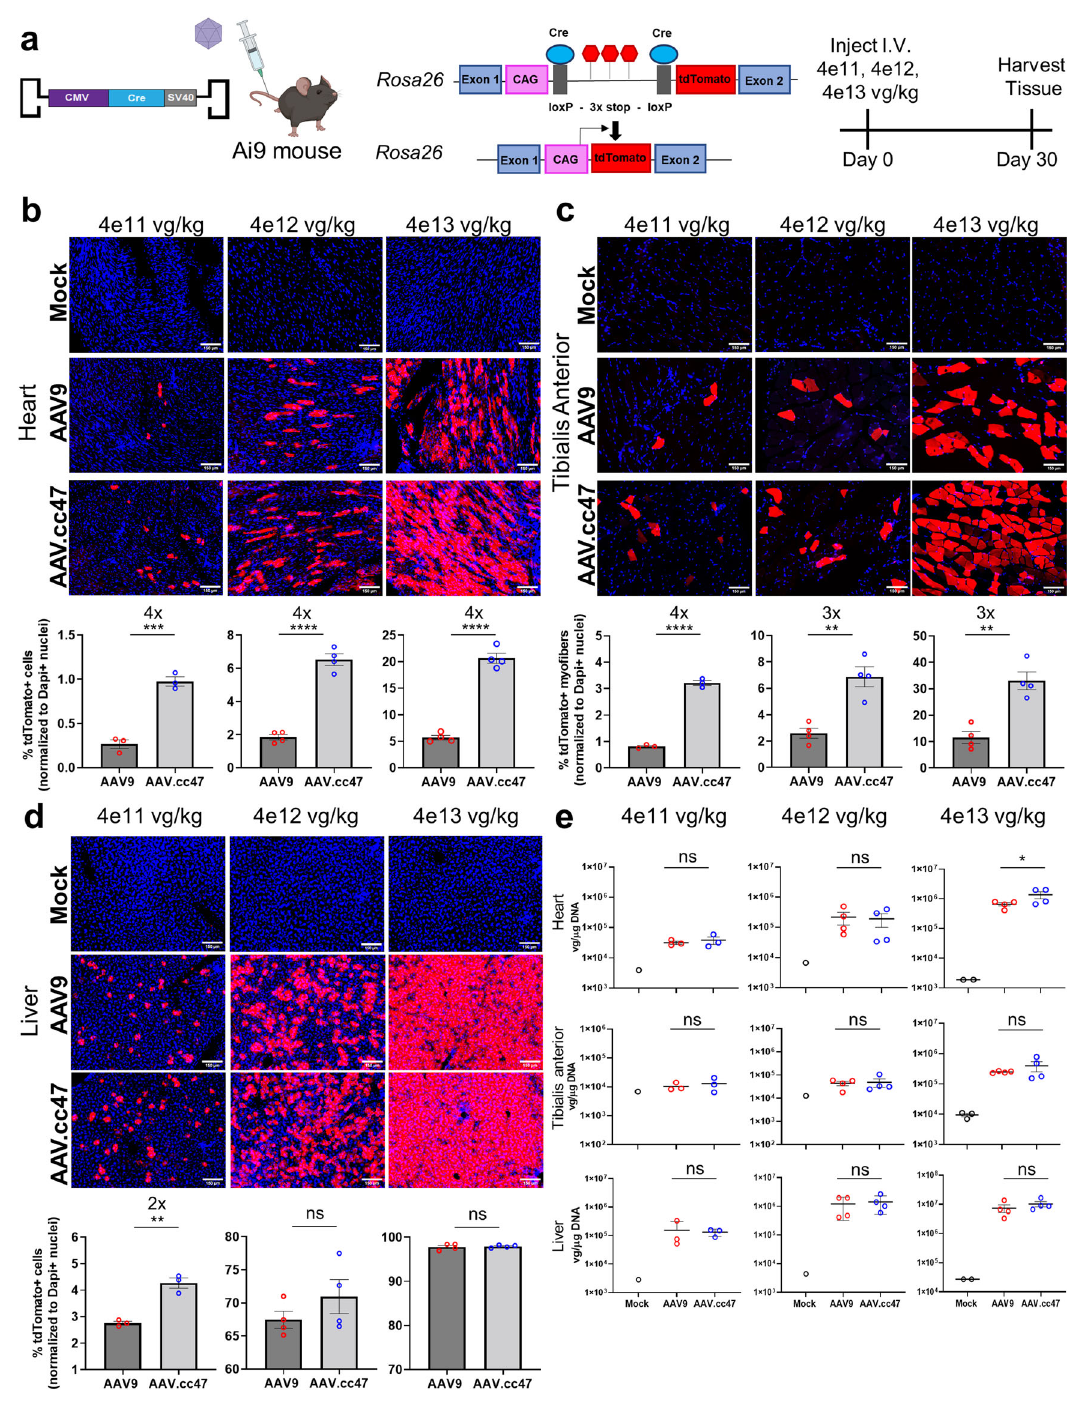
Fig. 3 | AAV.cc47 outperforms AAV9 in Cre recombination in the Ai9 reporter miceatalltesteddosesfollowingintravenous(IV)administration.a 8 – 10week oldAi9reportermice( n =4)wereinjectedintravenouslyat4e11,4e12,and4e13vg/ kg with AAV9 (red) or AAV.cc47 (blue). Vectors delivered a single stranded AAV genome with the cytomegalovirus (CMV) promoter driving Cre recombinase. Representativeimmuno fl uorescenceimagesandquanti fi cationfortdTomato(red) and DAPI (blue)formice injectedat each dose in heart ( b ),tibialis anterior ( c ),and liver ( d ). Fifty micrometers thick cross sections were obtained via a vibratome for heart and liver, while 7 μ m thick cross sections were obtained for skeletal muscle viacryostat.TotalnumberoftdTomato+cells(heartandliver)andtotalnumberof tdTomato+ myo fi bers (tibialis anterior) were counted and normalized to the total numberofDAPI+nucleiineachtissue. e Vectorgenomecopynumbersper μ gDNA were calculated by normalizing Cre recombinase copy numbers to total μ g DNA